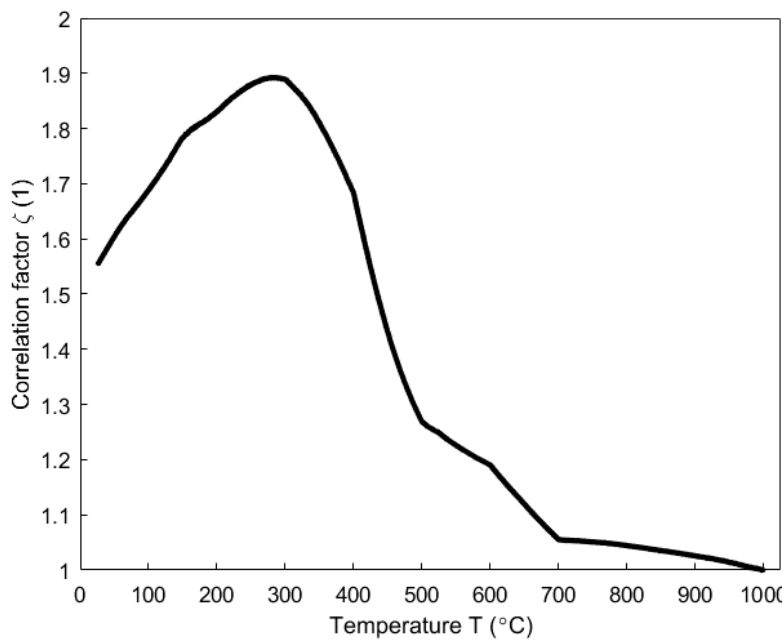
Figure 11. Evolution of the correlation factor as a function of temperature [34].